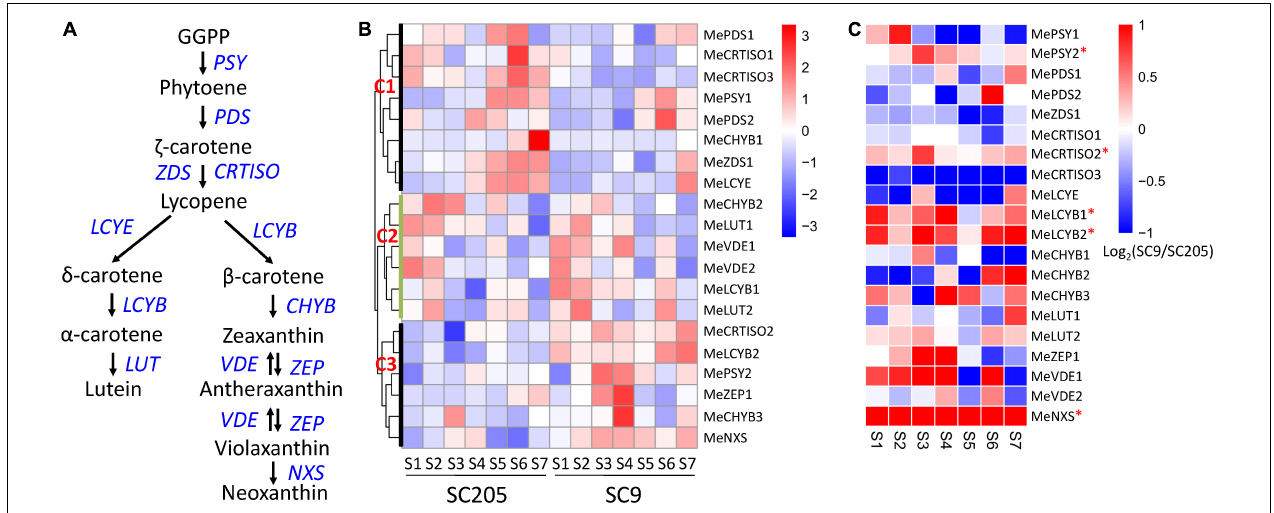
FIGURE 6 | Expression changes of carotenoid biosynthesis genes during tuberous root development. (A) Summary of carotenoid biosynthesis pathways, in which the genes are highlighted in blue. (B) Expression profiles of carotenoid biosynthesis genes between SC9 and SC205 during tuberous root development. (C) Expression fold-change of carotenoid biosynthesis genes between SC9 and SC205 during tuberous root development. The genes suffixed with a star ( ∗ ) are up-regulated in SC9 than SC205 during most developmental stages and may participate in the yellow formation of cassava tuberous roots.